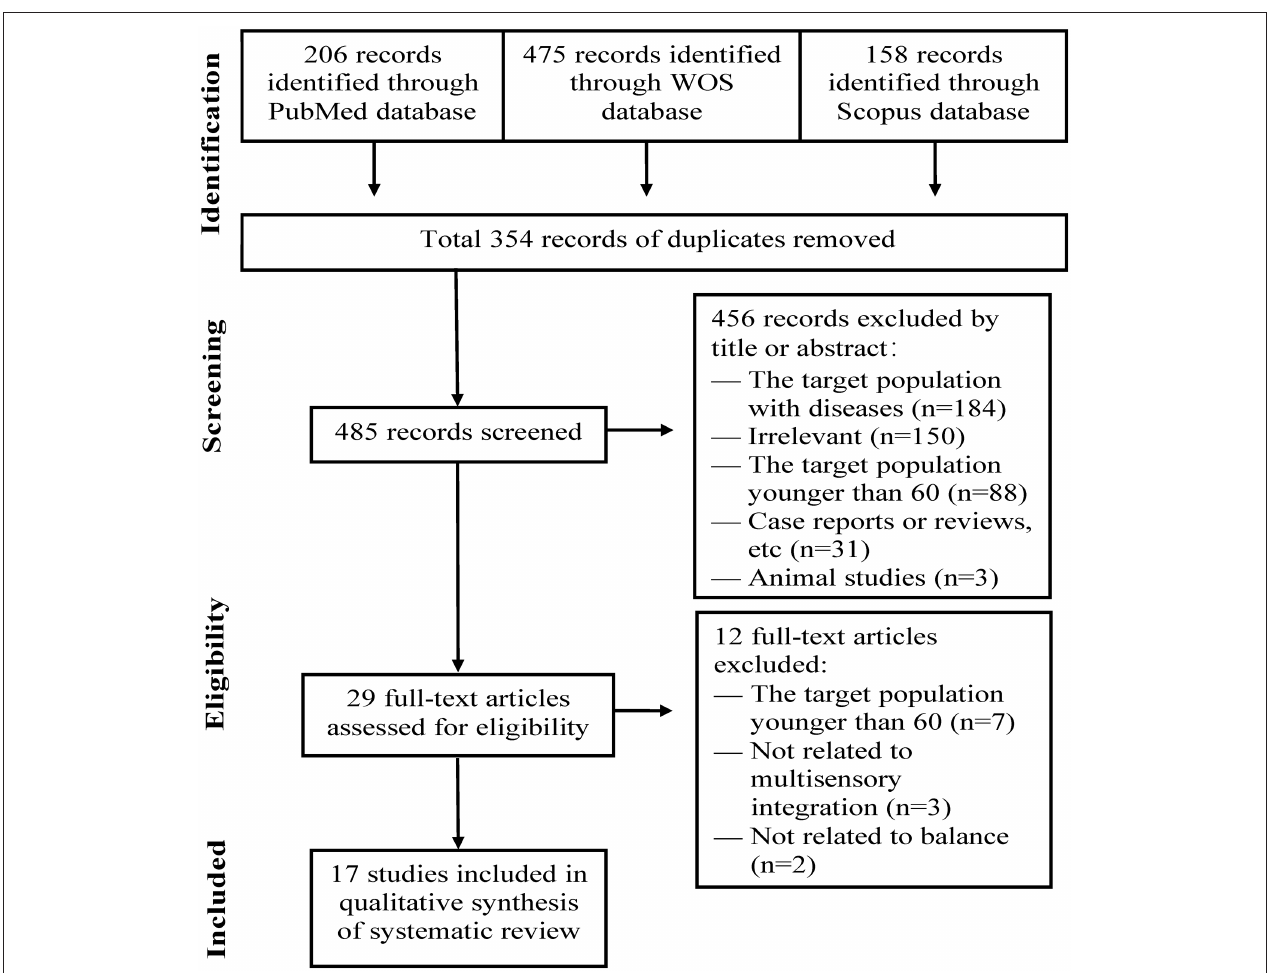
FIGURE 1 | PRISMA flow diagram of study selection